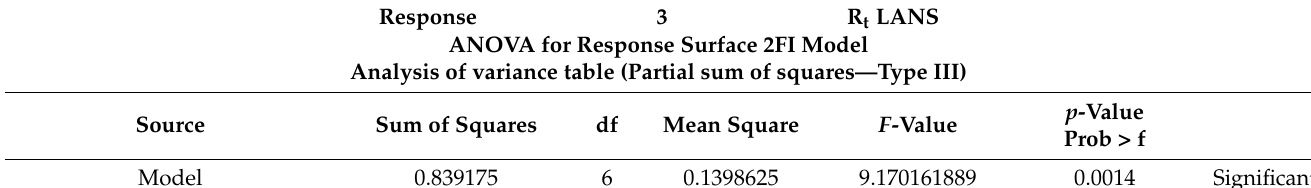
Table 8. ANOVA for response surface for R t LANS.